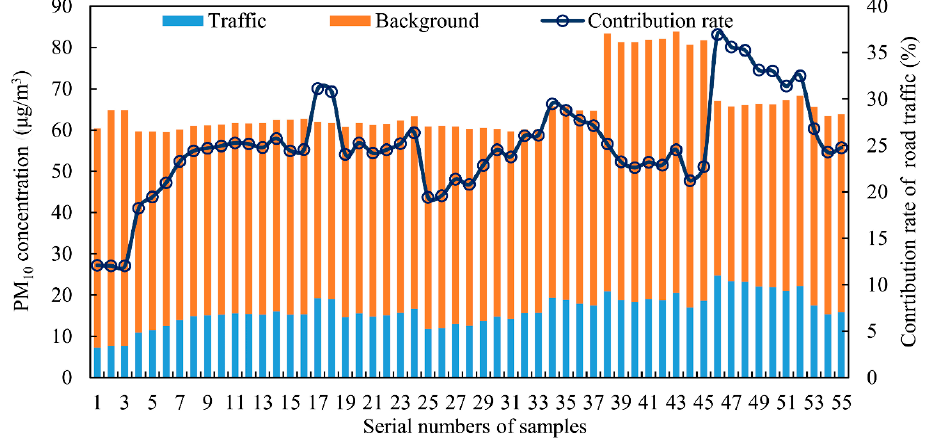
Figure 4. PM 10 concentrations ( μ g/m 3 ) and contribution rates of traffic to PM 10 concentrations (%) in the roadside environment.